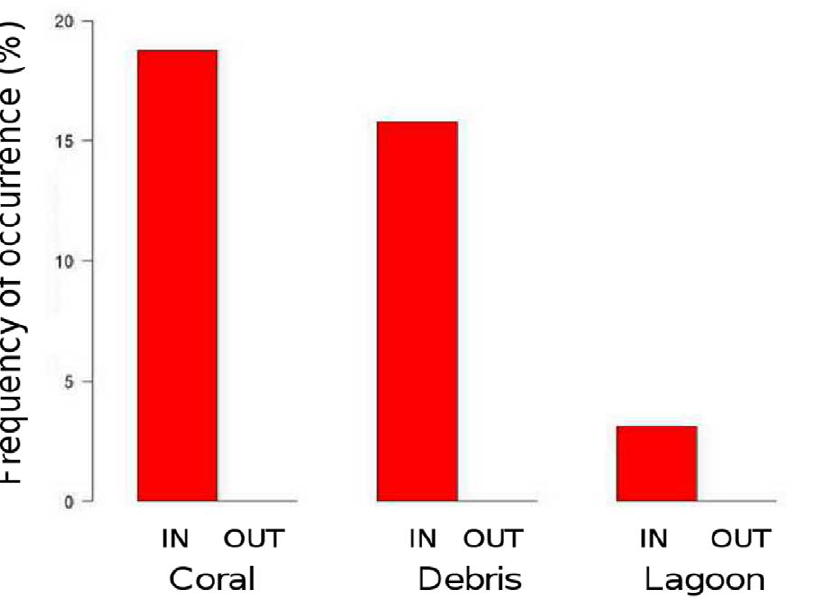
Figure 9. Frequency of occurrence of marine turtles. Frequencies were plotted per habitat (labeled on the X-axis) and per protection status (protected areas in dark grey and unprotected areas in light grey).